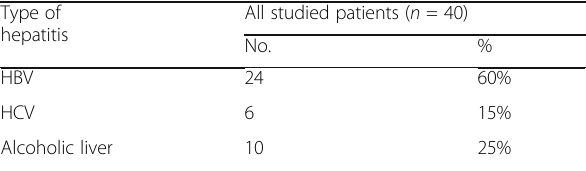
Table 2 Type of hepatitis of all studied patients Type of hepatitis